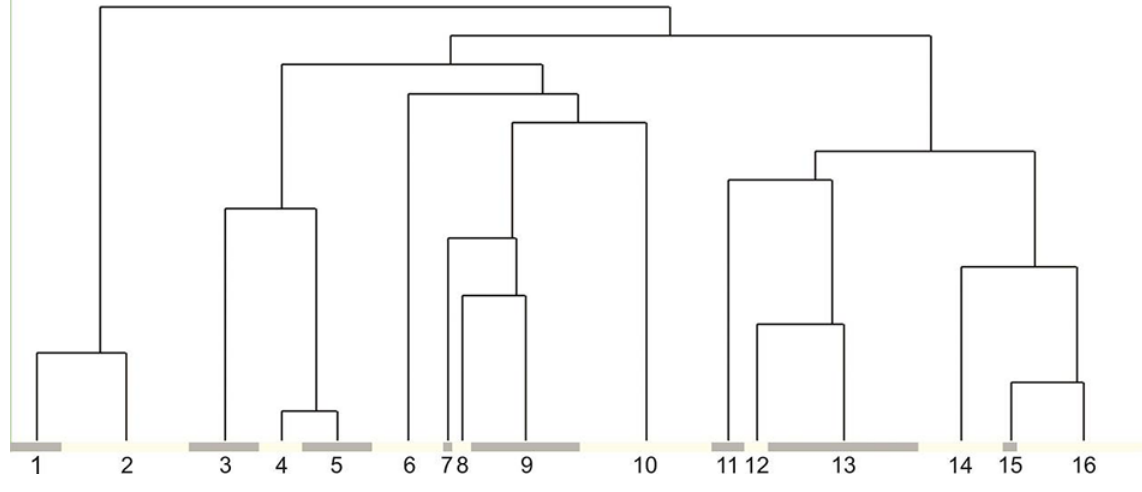
Figure 2 Dendrogram illustrating the assignment of relevé groups identified by TWINSPAN to particular syntaxonomical